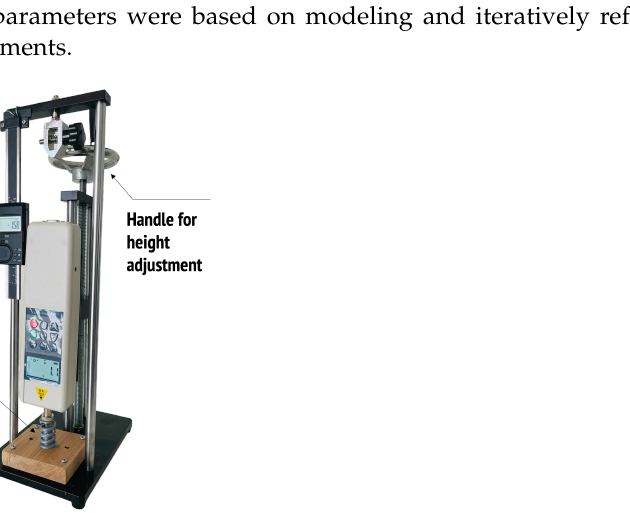
Figure 1. Experimental setup for the force-displacement